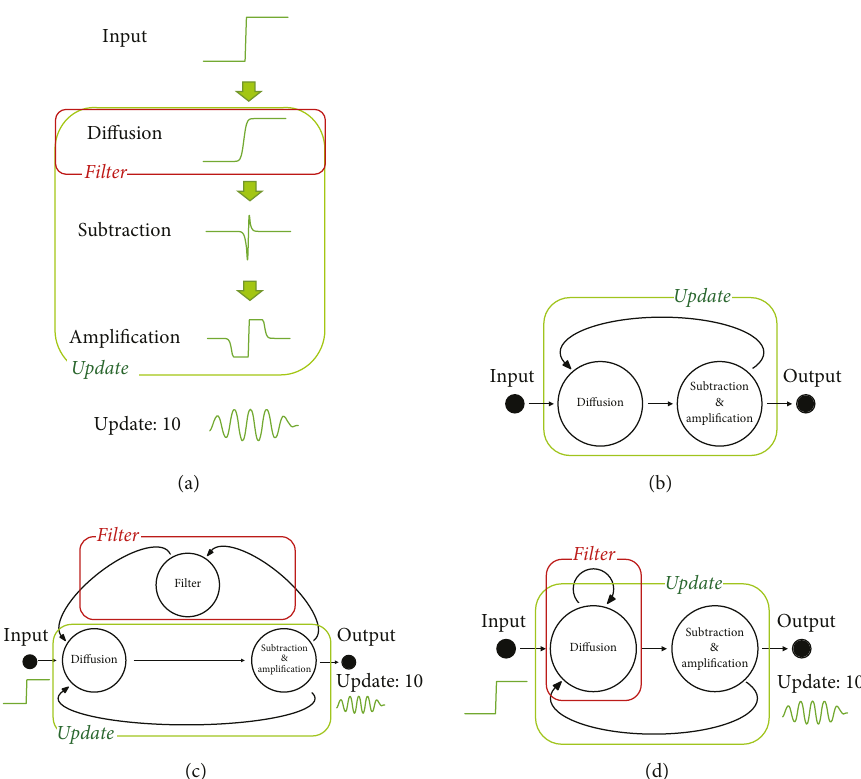
Figure 1: One-dimensional pattern generation concept. (a) Data-flow diagram showing a step input to the Update and Filter processes and the corresponding sequential signal processing, resulting into a stable spacial intensity wave (1D pattern). (b) State-diagram showing the Update process, and (c) state-diagram showing the Update and Filtering processes and evidencing the iterative operation. (d) Integrated state-diagram, evidencing that the filtering is executed as one diffusion process.